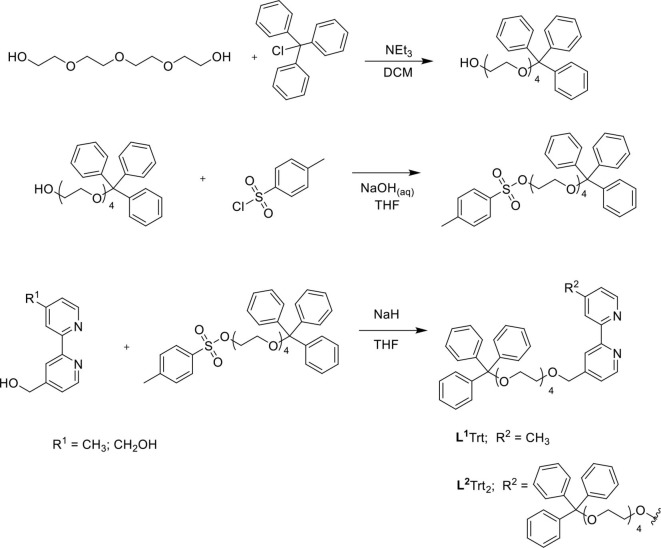
Synthesis of trityl protected bipyridine ligands (L1Trt and L2Trt2).